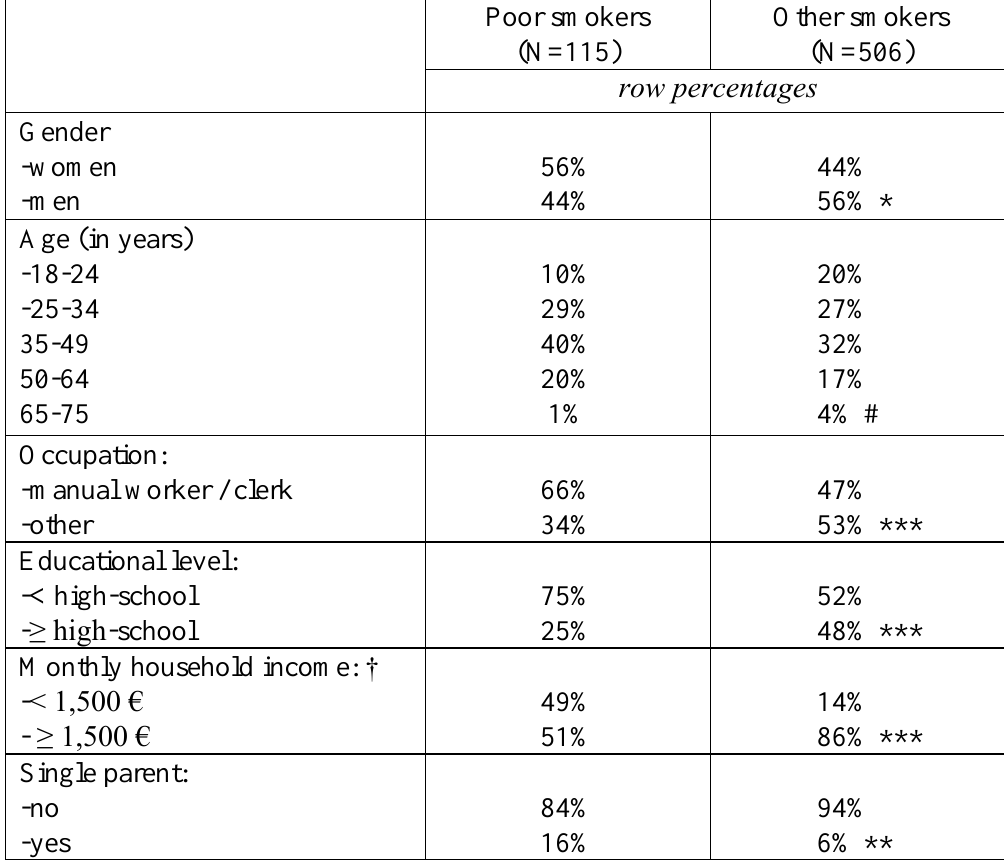
Table 1. Socio-demographic profile of poor smokers and other smokers, France,